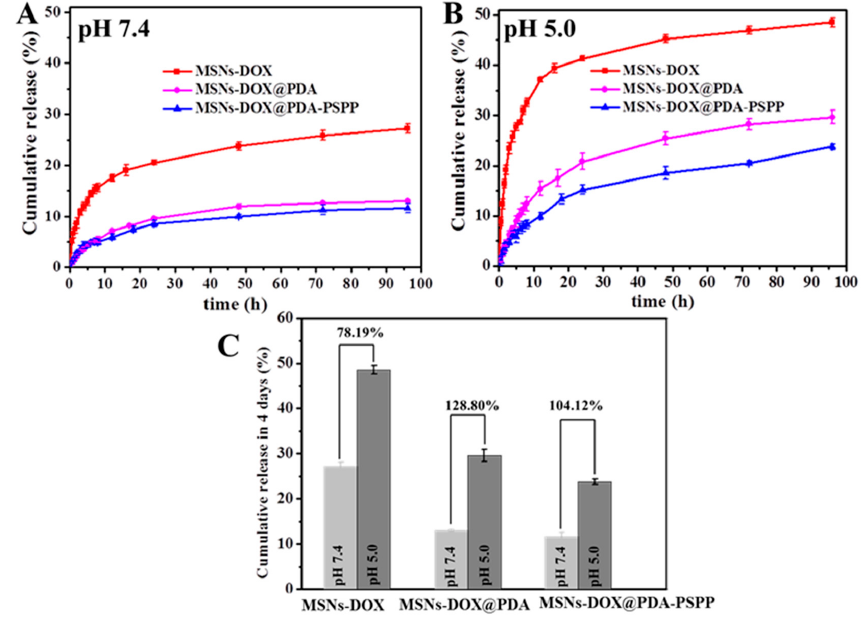
Figure 7. Cumulative release of DOX from MSNs-DOX, MSNs-DOX@PDA and MSNs-DOX@PDA-PSPP at ( A ) pH 7.4 and ( B ) pH 5.0. ( C ) The increase amplitude of drug release amount for MSNs-DOX,